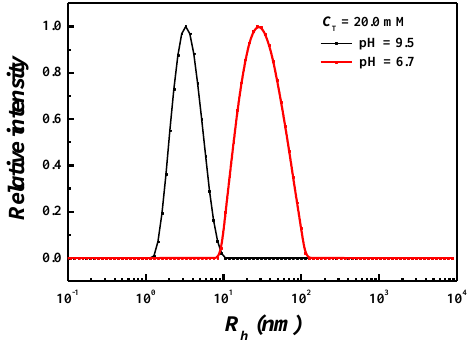
Figure 2. Size distributions of C 12 C 3 C 12 (SO 3 ) 2 aggregates obtained from DLS at C T = 20.0 mM and different pH conditions.